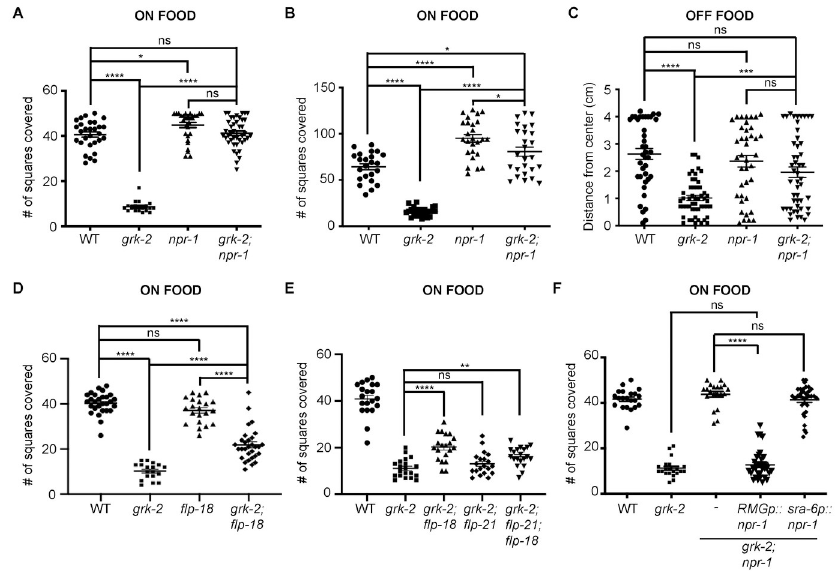
Fig 6. npr-1 suppresses the exploration defect of grk-2 mutant animals. (A) The npr-1(ky13) mutation suppresses the exploration defect of grk-2(gk268) mutants as assayed on 6 cm plates. Shown is the number of squares (out of 50) single animals covered in ~20 h. ( ���� , P < 0.0001. � , P < 0.05. ns, P > 0.05. One way ANOVA followed by a Bonferroni test. Error bars = SEM; n = 20–42). (B) The npr-1(ky13) mutation suppresses the exploration defect of grk-2(gk268) mutant as assayed on 10 cm plates. Shown is the number of squares (out of 150) single animals covered in ~20 h. ( ���� , P < 0.0001. � , P < 0.05. One way ANOVA followed by a Bonferroni test. Error bars = SEM; n = 23–25). (C) The npr-1 (ky13) mutation suppresses the dispersal defect of grk-2(gk268) in the absence of food. ( ���� , P < 0.0001. ��� , P < 0.001. ns, P > 0.05. One way ANOVA followed by a Bonferroni test. Error bars = SEM; n = 39–51). (D) The flp-18(db99) mutation partially but significantly suppresses the exploration defect of grk-2(gk268) . ( ���� , P < 0.0001. ns, P > 0.05. One way ANOVA followed by a Bonferroni test. Error bars = SEM; n = 20–30). The data points shown for WT and grk-2 mutant are the same as in S4A Fig (these experiments were run in parallel). (E) The flp-21(ok889) mutation does not suppress the exploration defect of grk-2(gk268) . ( ���� , P < 0.0001. �� , P < 0.01. ns, P > 0.05. One way ANOVA followed by a Bonferroni test. Error bars = SEM; n = 20–26). (F) Expression of ncs-1p :: nCre and flp-21p ::LoxStopLox::NPR-1 (expression in RMG neurons (54); RMGp :: npr-1 , transgene yakEx206 ) reverses the npr-1 suppression of the exploration defect of grk-2(gk268) mutant. Expression of npr-1 cDNA under the sra-6 promoter (expression in ASH and ASI neurons; sra-6p :: npr-1 , transgene yakEx209 ) fails to reverse the npr-1 suppression of the exploration defect of grk-2(gk268) ( ���� , P < 0.0001. ns, P > 0.05. One way ANOVA followed by a Bonferroni test. Error bars = SEM; n = 21–